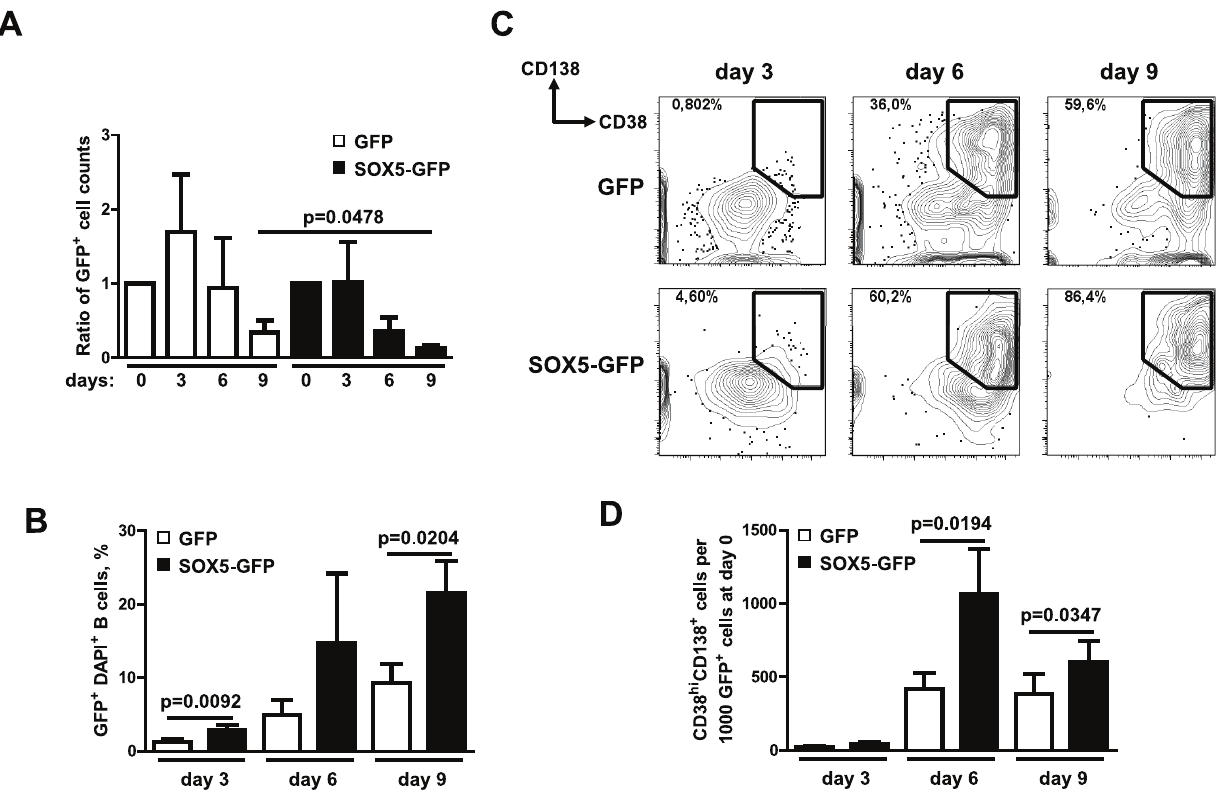
Figure 6. SOX5 modulates invitro terminal B cell differentiation. (A) Proliferation measured as the ratio of absolute numbers of GFP + cells in the samples. Absolute cell counts of GFP + cells on day 0 are taken as 1.0 and the data are expressed as mean 6 SD. Summary of three independent experiments are depicted. (B) Frequencies of GFP + DAPI + cells within GFP (control) and SOX5-GFP-transduced peripheral blood B cells cultivated in vitro . (C) Plasma cell differentiation analyzed by FACS in peripheral blood B cells stably transduced either with GFP (control) or SOX5-GFP fusion construct upon in vitro stimulation with IL4 + CD40L + IL21. DAPI-negative GFP + gated cells were analyzed by FACS for the plasma cell markers CD138 and CD38 at days 3, 6 and 9. Gates indicate the frequencies of CD138 + CD38 hi plasmablasts in each FACS plot. Representative FACS plots of three independent experiments are shown. (D) Numbers of CD138 + CD38 hi plasmablasts in GFP (control) and SOX5-GFP-transduced B cells at days 3, 6 and 9 referring to CD38 hi CD138 + cells per 1000 GFP + cells at day 0. Cell numbers are depicted as mean 6 SD and t-test p-values indicate the significant differences. Summary of three independent experiments are shown.